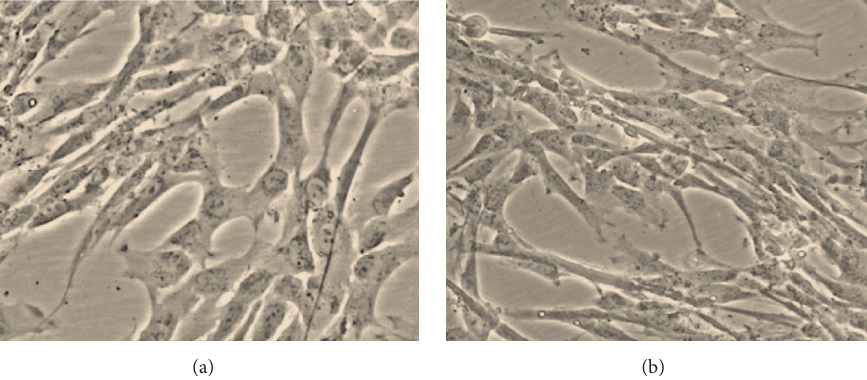
Figure 1: Umbilical cord MSCs are plastic-adherent with fibroblast-like morphology. Representative phase-contrast images of cultured cells generated using (a) collagenase digestion or (b) homogenization of umbilical cord tissue.